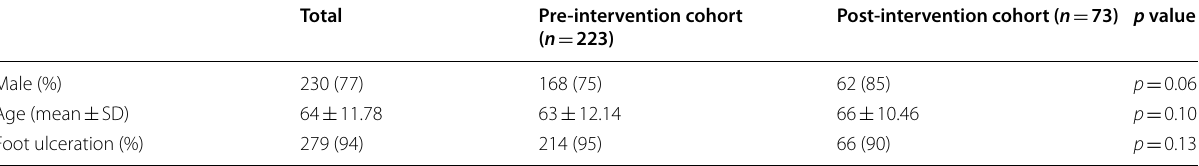
Table 1 Patient demographic characteristics for the pre‑ and post‑intervention cohorts